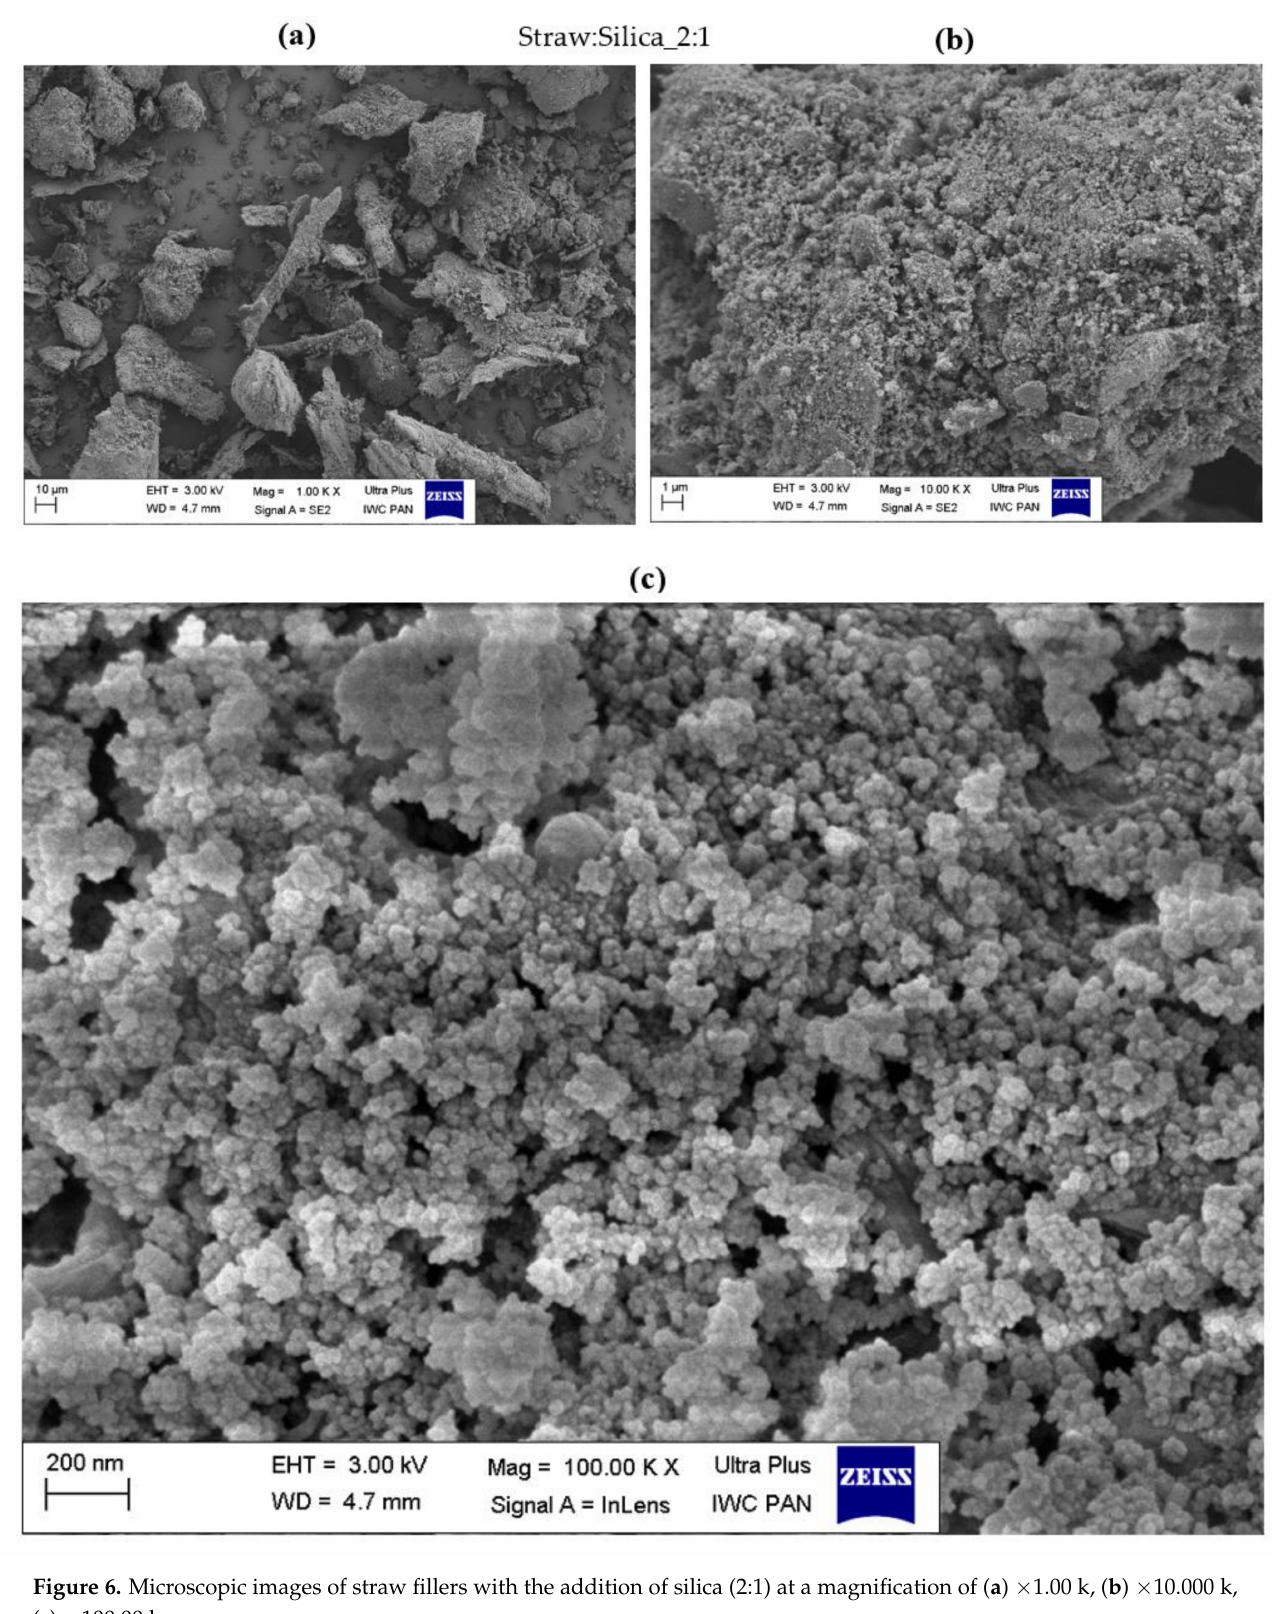
Figure 6. Microscopic images of straw fillers with the addition of silica (2:1) at a magnification of ( a ) × 1.00 k, ( b ) × 10.000 k, ( c ) × 100.00